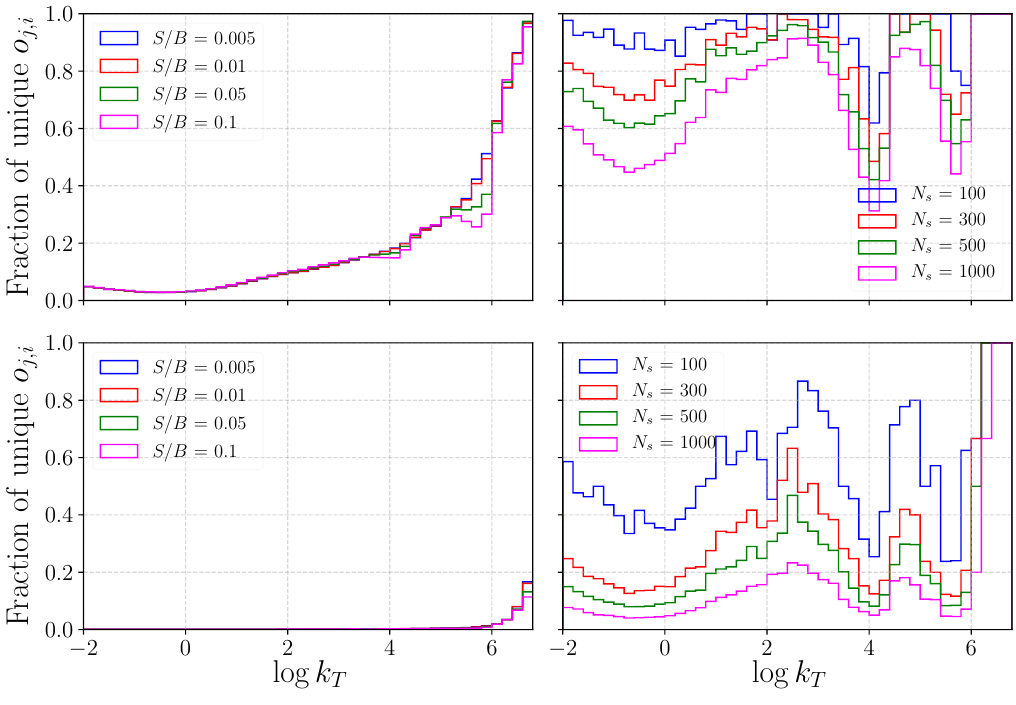
Figure 11 . Fraction of unique measurements in W 0 event samples, using all the Lund basis observables ( m 0 , log R= (cid:1), log k T , z , log R=(cid:20) , ) (top line) and only the pair (log k T , log R= (cid:1)) (bottom line). On the left we show samples of 9 10 4 events consisting of di(cid:11)erent fractions (cid:2) of mixed signal ( W 0 ) and background (QCD) events, while on the right we show the results for di(cid:11)erent numbers of pure signal ( W 0 )